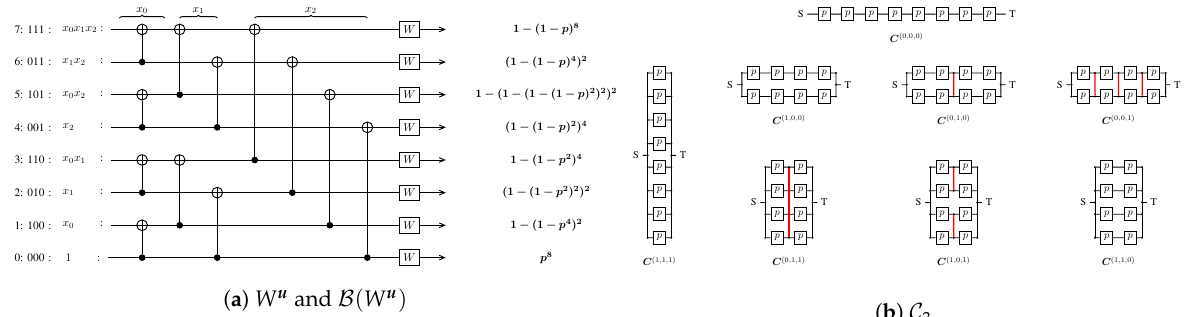
Figure 3. Combined circuit as defined by Arikan [1], the Bhattacharyya parameter of the corresponding synthetic channels and the compositions in C 3